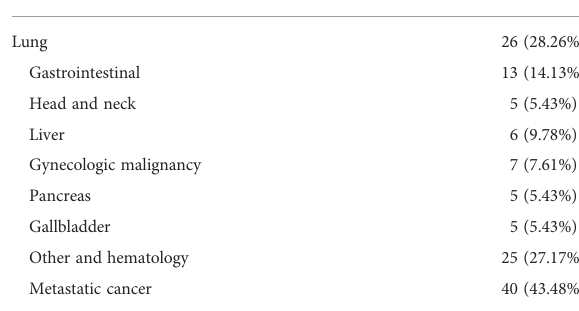
TABLE 2 Distribution of cancer types among patients with